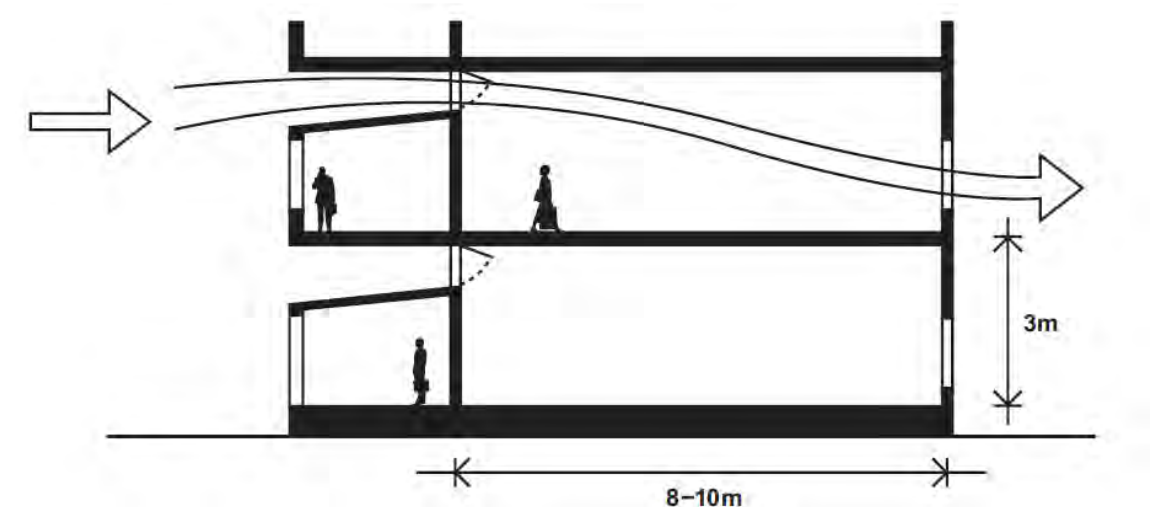
Figure 4. Cross ventilation for single loaded corridor design (St. Clair,2009)